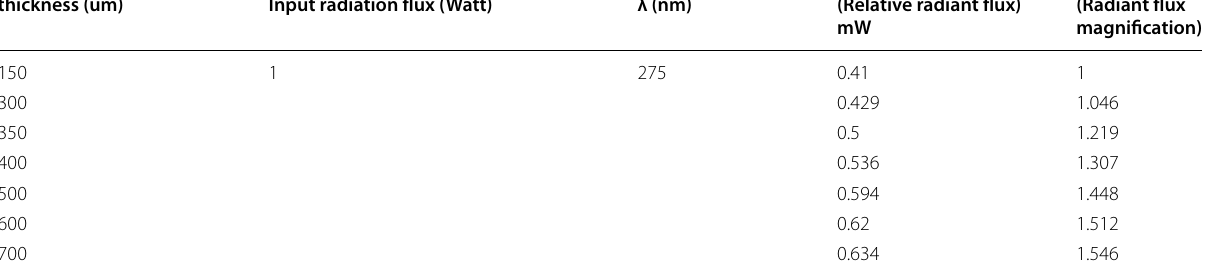
Table 2 LEE simulation results for a light guide layer thickness of 150–700 μm